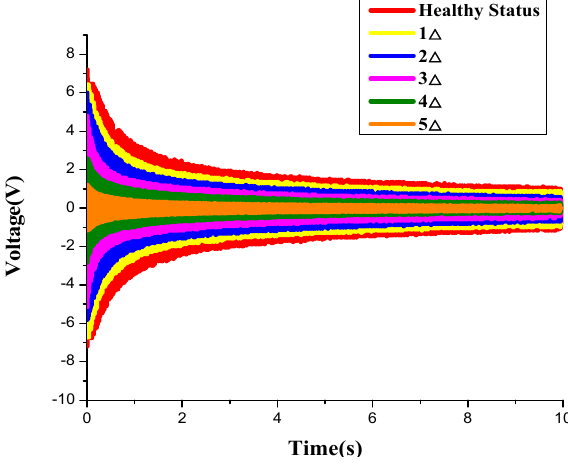
Figure 20. The variation of voltage value of the WSAs under different damage states.